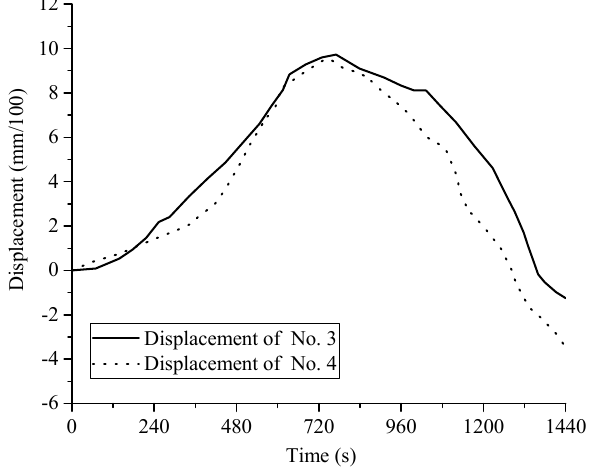
Figure 8. Arrangement of displacement meters in existing tunnels under mixed crossing (unit: mm).